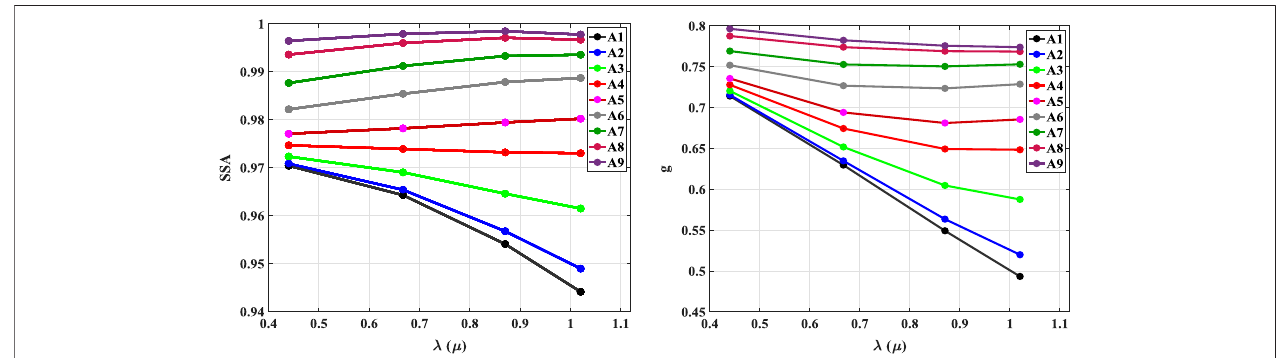
FIGURE 1 | Single Scattering Albedo (SSA) and asymmetry parameter (g) for selected A2010 (RH = 80%). The models are sorted according to size fractions with increasing coarse modes from A1 through A9.